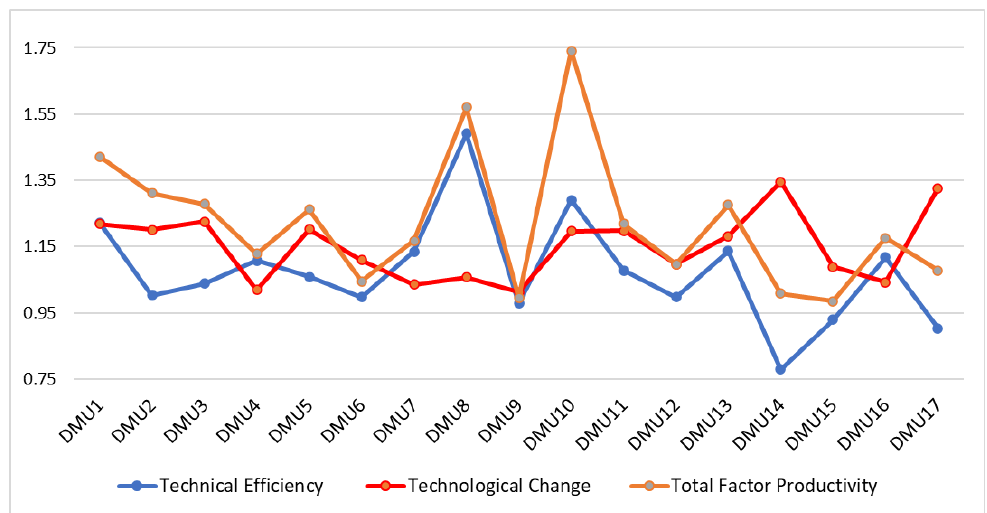
Figure 7. Comparison of average technical, technological, and total productivity index.